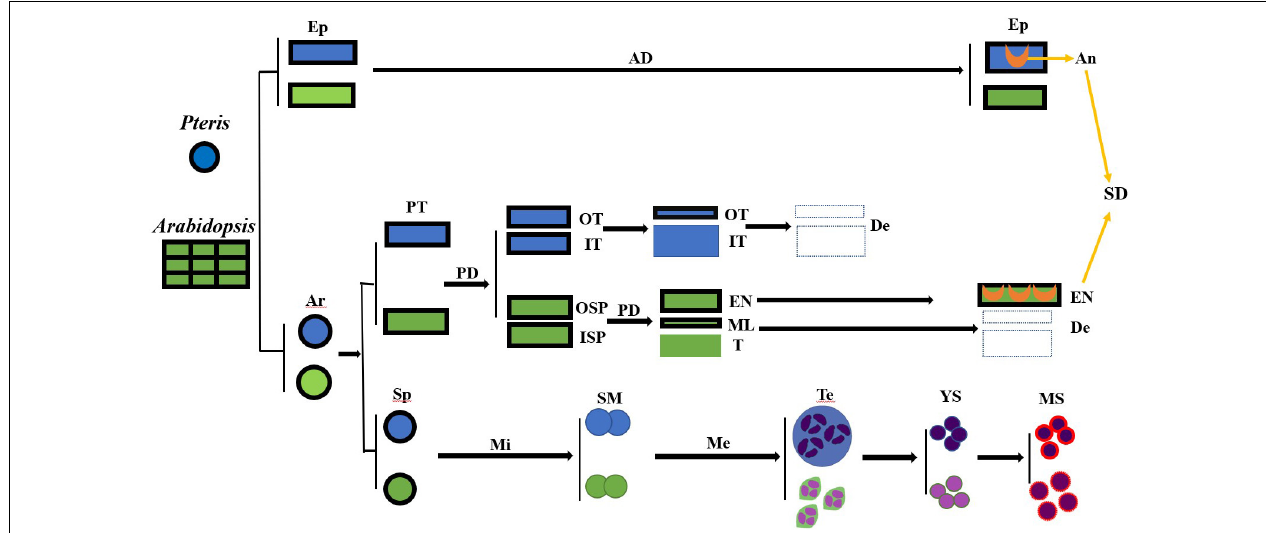
FIGURE 7 | The cell lineages of the sporangia of Pteris and the anther of Arabidopsis. AD, anticlinal division; An, annulus; TMI, tetrahedral mother initial cell; De, degraded; Ep, epidermis; En, endothecium; ISP, inner secondary parietal cell; IT, inner tapetum layer; Me, meiosis; Mi, mitosis; ML, middle layer; MS, mature spores; OSP, outer secondary parietal cell; OT, outer tapetum layer; PD, periclinal division; PT, primary tapetum layer; SD, sporangia dehiscence; SM, the spore mother cells; Sp, sporogenous cell; T, tapetum; Te, tetrad; YS, young